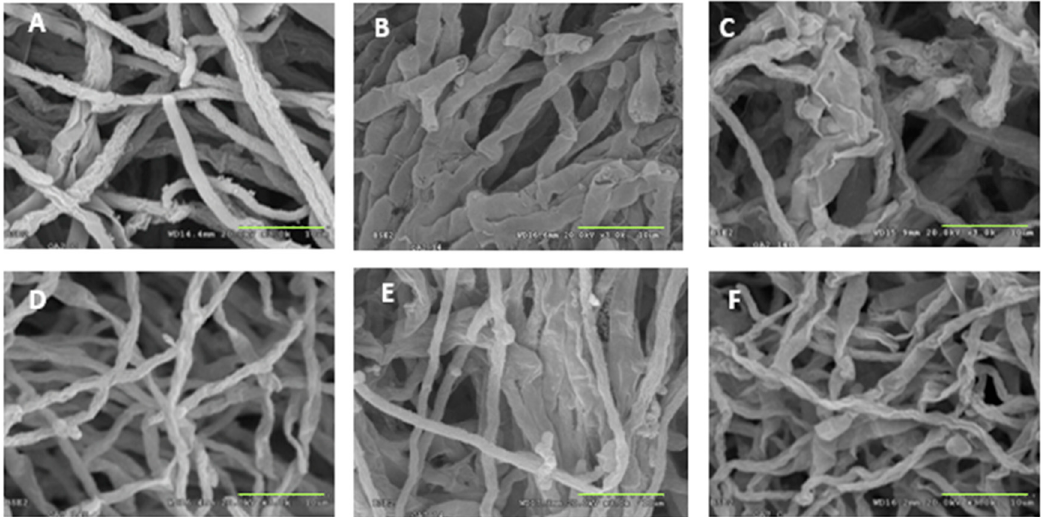
Figure 2. SEM images of P. ostreatus ( A – C ) and P. eryngii ( D – F ) grown in malt extract liquid broth for 14 days without ( A , D ) and with TCE at 14 mg L − 1 ( B , E ) and 140 mg L − 1 ( C , F ). The secretion of the extracellular enzymes laccase and MnP are another indication of fungal functioning [40]. Although P. ostreatus did not express laccase in the absence of